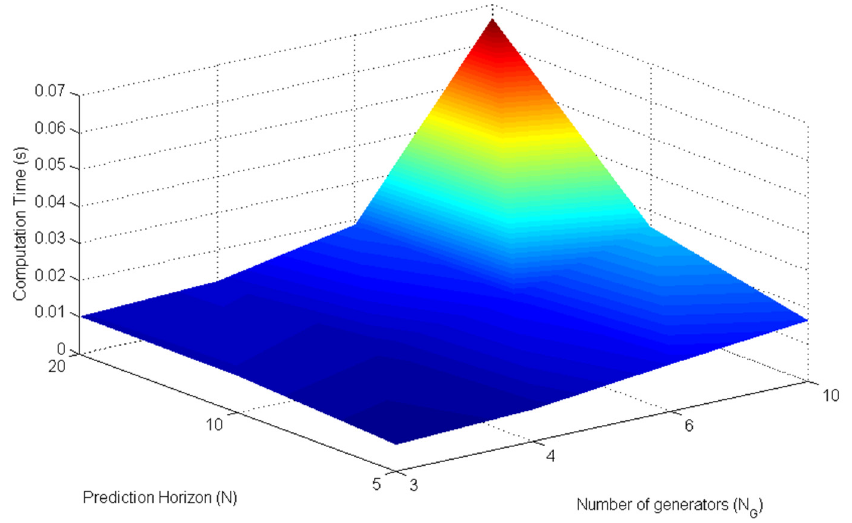
Figure 6. Average computation times according to operation